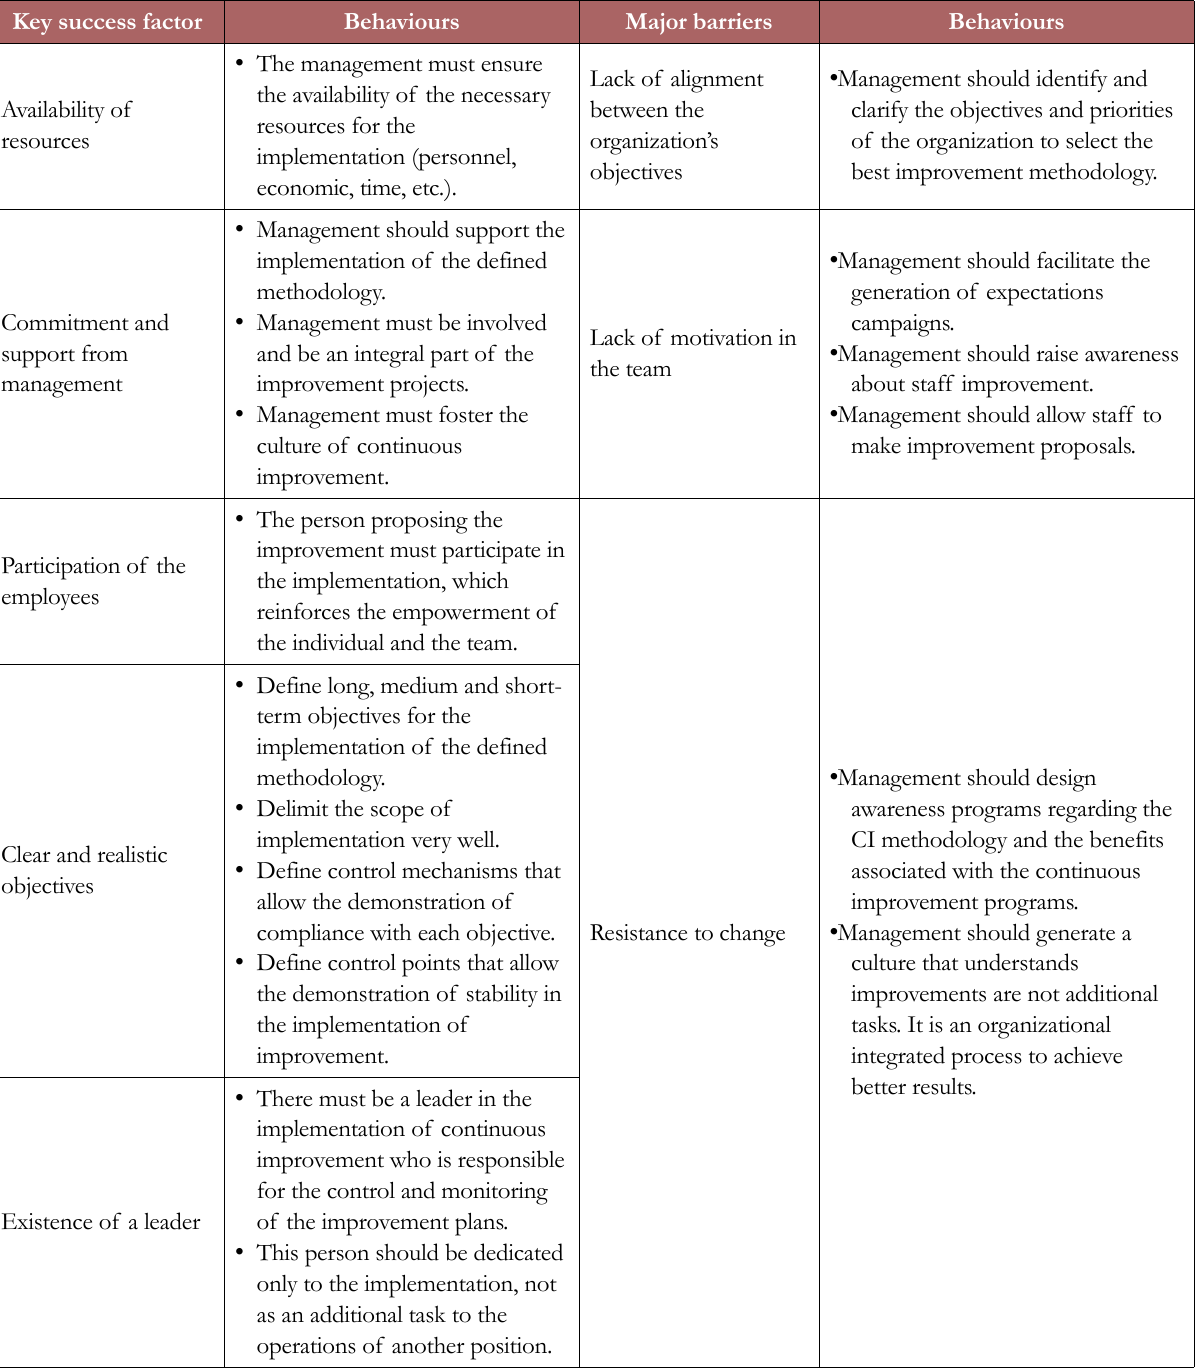
Table 4. Main behaviours applied by the organizations for the sustainability of continuous